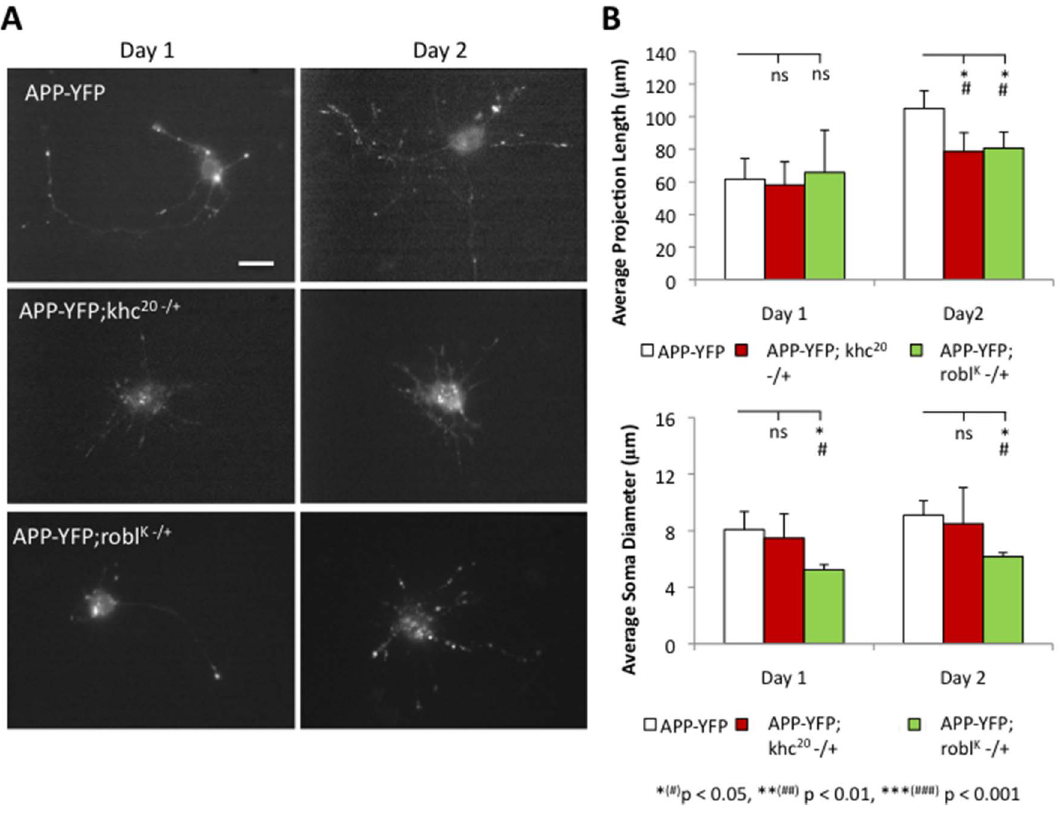
Figure 3. 50% reduction of kinesin-1 or dynein is sufficient to perturb neuronal growth. ( A ) Representative neuronal cultures expressing APP-YFP and APP-YFP with 50% genetic reduction of either kinesin-1 or dynein are shown at day 1 and day 2. Note that short neurites are observed in cultures from 50% reduction of kinesin-1 and dynein in contrast to WT cultures. Bar=10 microns. ( B ) Quantitative analysis of neuronal growth as assayed by projection length shows significant decreases in growth with 50% genetic reduction of kinesin-1 and dynein. At day 1 no significant difference in neurite length was observed between neurites containing 100% motor proteins, 50% kinesin-1 or 50% dynein. By day 2, neurites containing 100% motor proteins significantly outgrew neurites containing 50% kinesin-1 (p=0.027) or dynein (p=0.021). No significant changes were seen in the cell body diameters in neurons containing 100% motor proteins or 50% kinesin-1, but 50% reduction of dynein significantly inhibited the growth of cell bodies (p day1 =0.031 and p day2 =0.036). N=10 cells; *( # ) p , 0.05, **( ## ) p , 0.01, ***( ### ) p , 0.001 by two-tailed Student t-test (*) and by Bonferroni’s test ( # ). NS=not significant. doi:10.1371/journal.pone.0097237.g003 PLOS ONE |